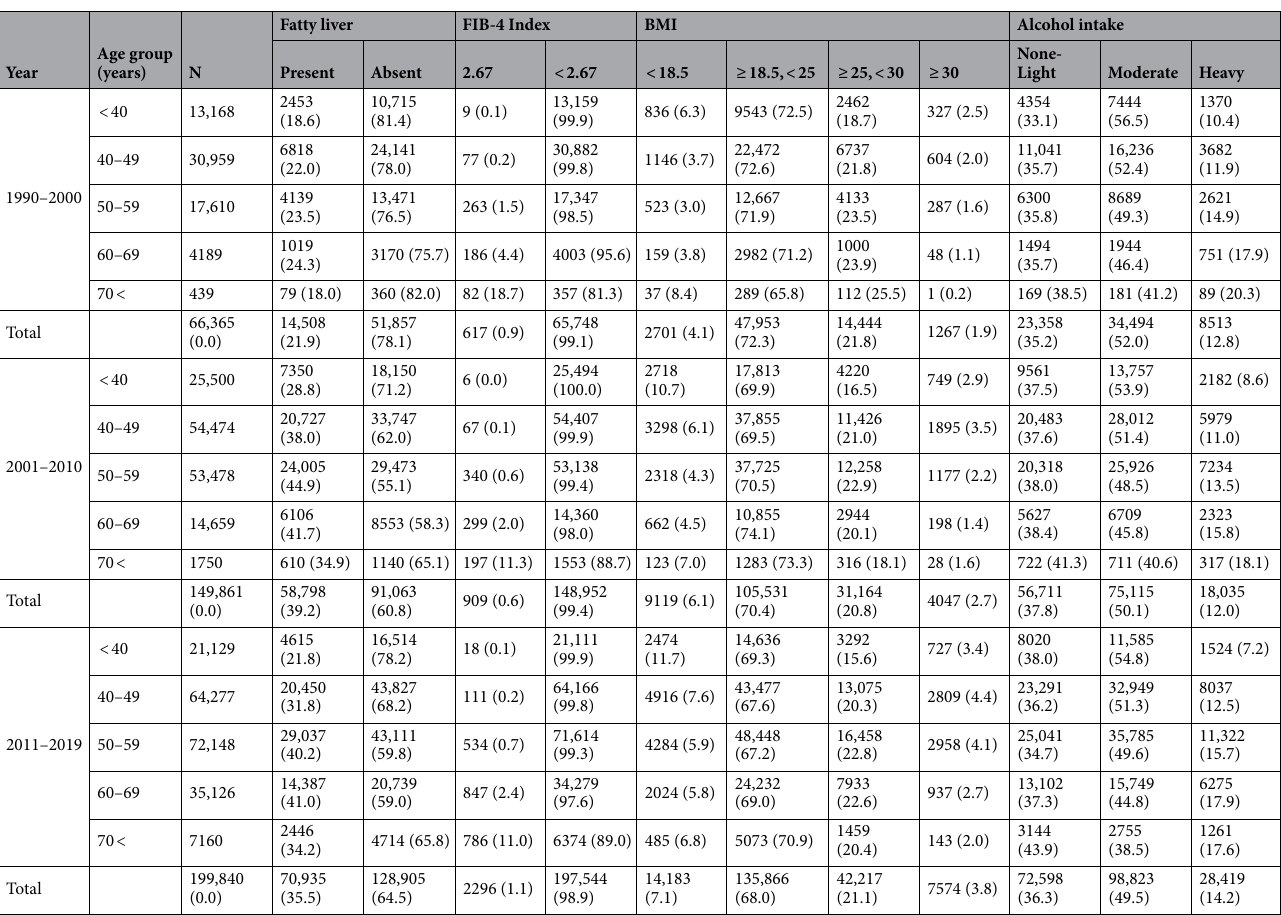
Table 1. Detailed data on the prevalence of fatty liver, fibrosis-4 (FIB-4) index, body mass index (BMI), and alcohol intake for all the study subjects who were categorized into five age groups and three periods (1990– 2000, 2001–2010, and